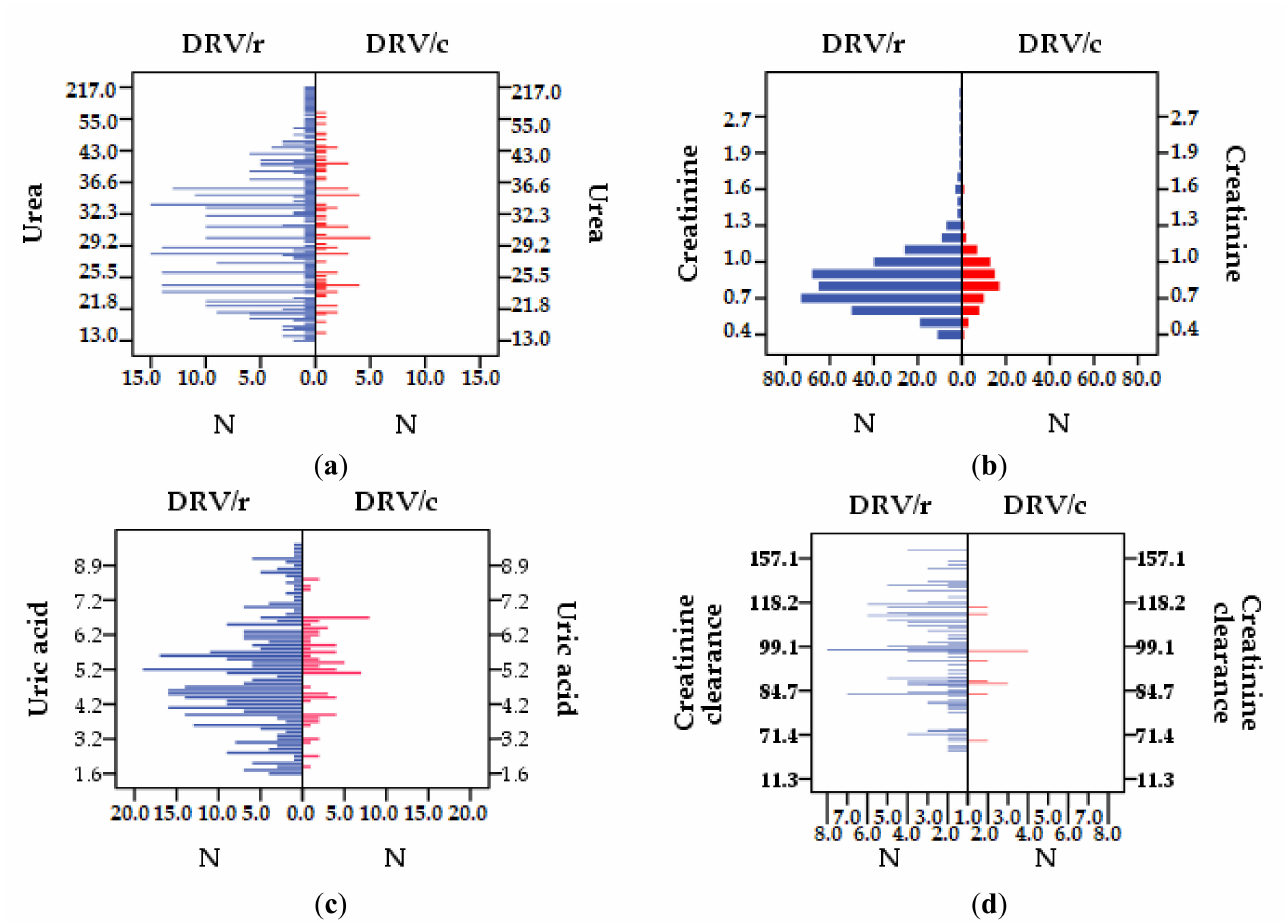
Figure 7. Distribution of parameter values for the entire cohort. Difference between batches, DRV/r and DRV/as renal function parameter values: ( a ) urea (mg/dL), ( b ) creatinine (mg/dL), ( c ) uric acid (mg/dL), ( d ) creatinine clearance